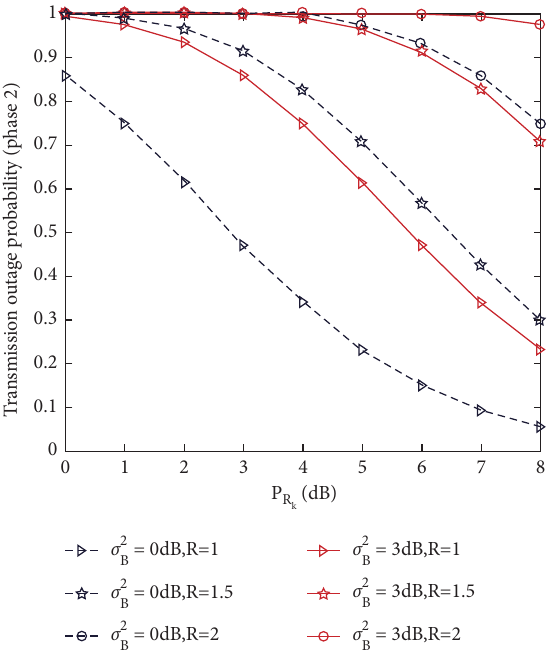
R j with dif- | 2 � 1, and σ 2 � 0 dB . B j W